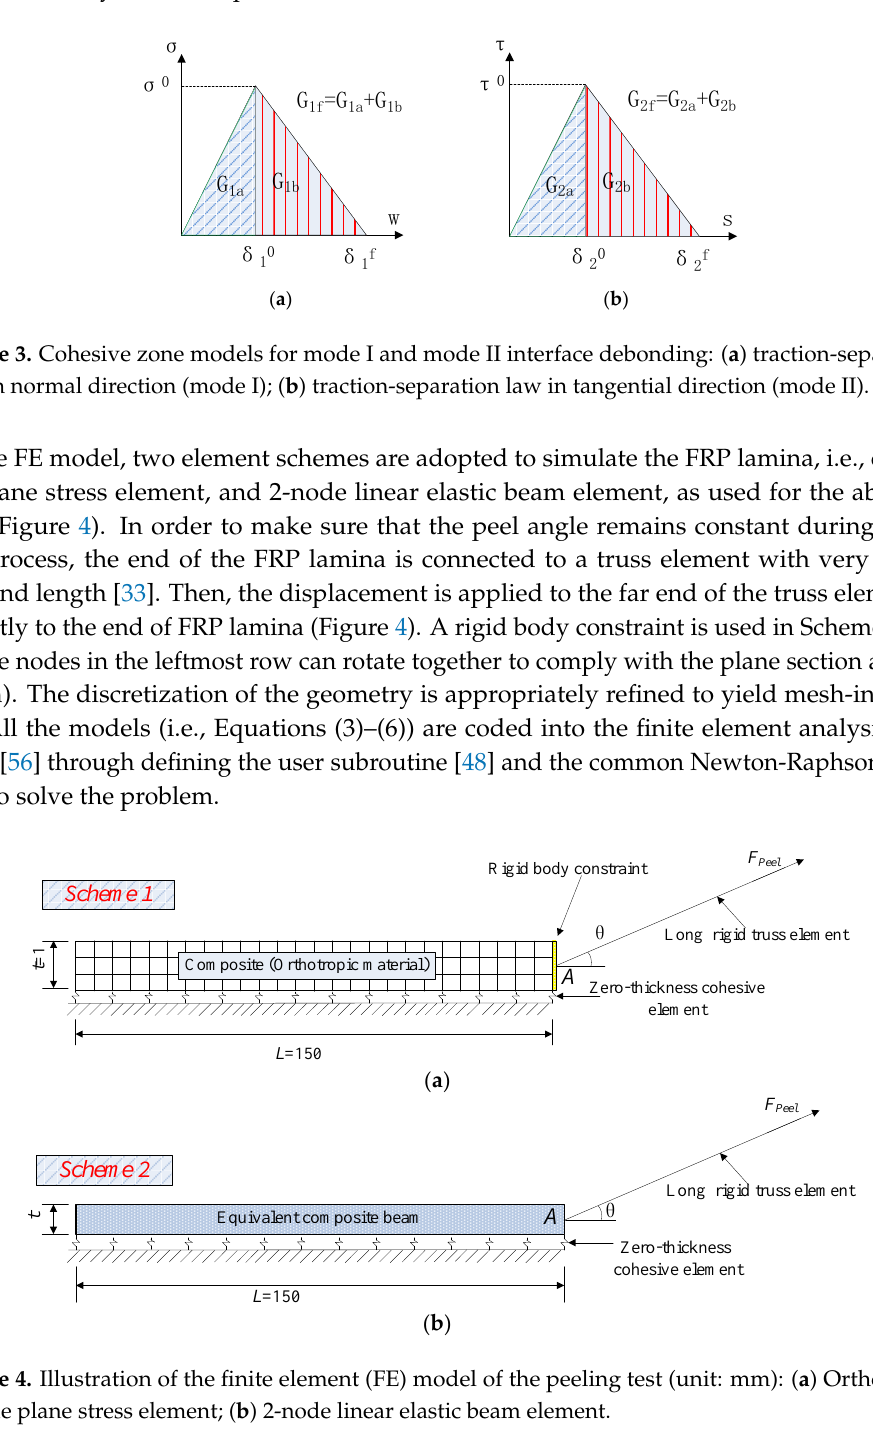
Figure 4. Illustration of the finite element (FE) model of the peeling test (unit: mm): ( a ) Orthotropic 4-node plane stress element; ( b ) 2-node linear elastic beam element.